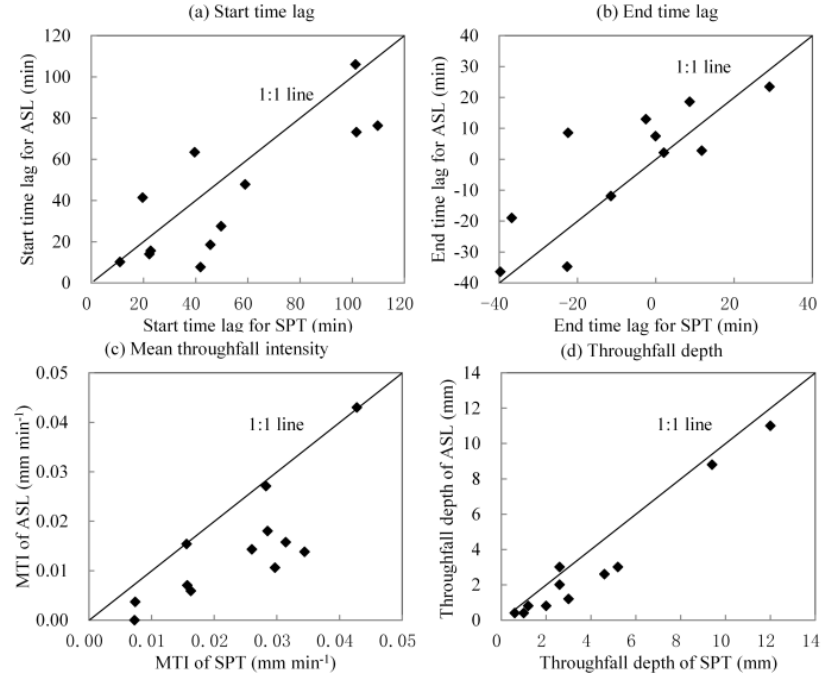
Figure 4. Comparison of depth, mean intensity, start time lag (STL), and end time lag (ETL) of throughfall between the two sites.